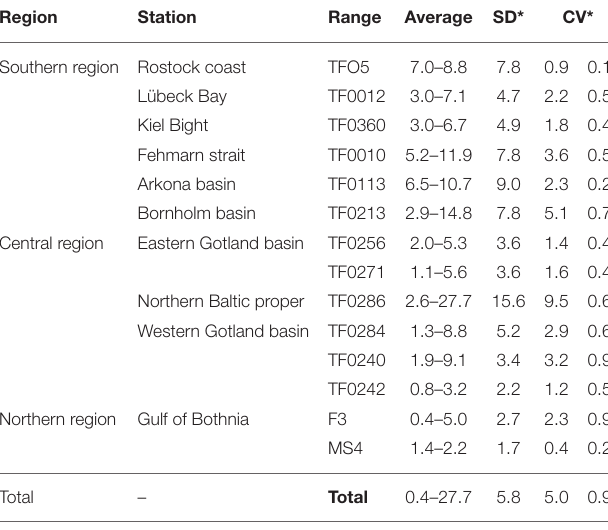
TABLE 1 | Variation in the vertical distribution of microplastics (items L − 1 ) in the water column in different regions of the Baltic Sea. Region